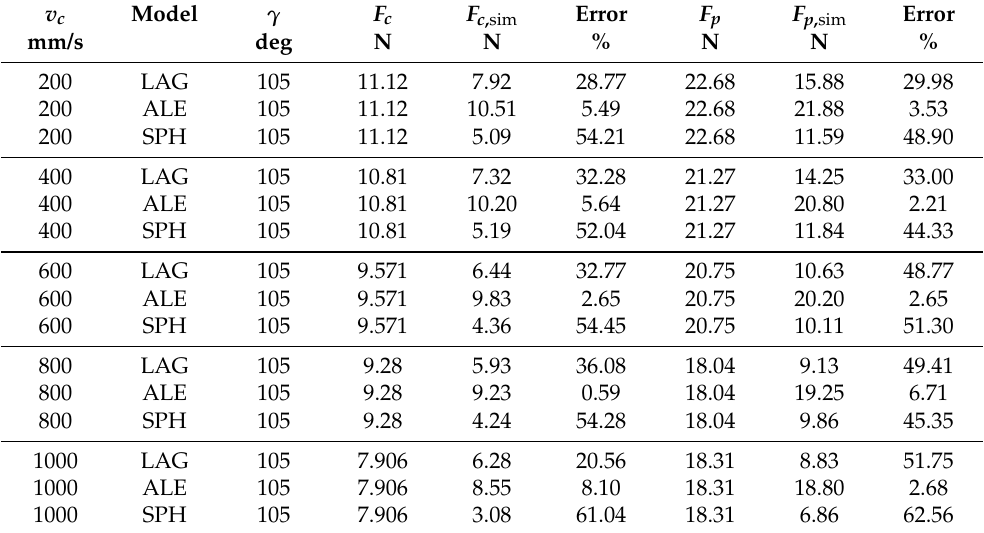
Table 3. Comparison of measured cutting and passive force in a single grit scratch experiment with different numerical methods with an indenter cone angle of 105 ◦ . In the table, F c represents the experimental measured cutting force, F p represents the experimental measured passive force, F c ,sim represents the predicted cutting force, and F p ,sim represents the predicted passive force.